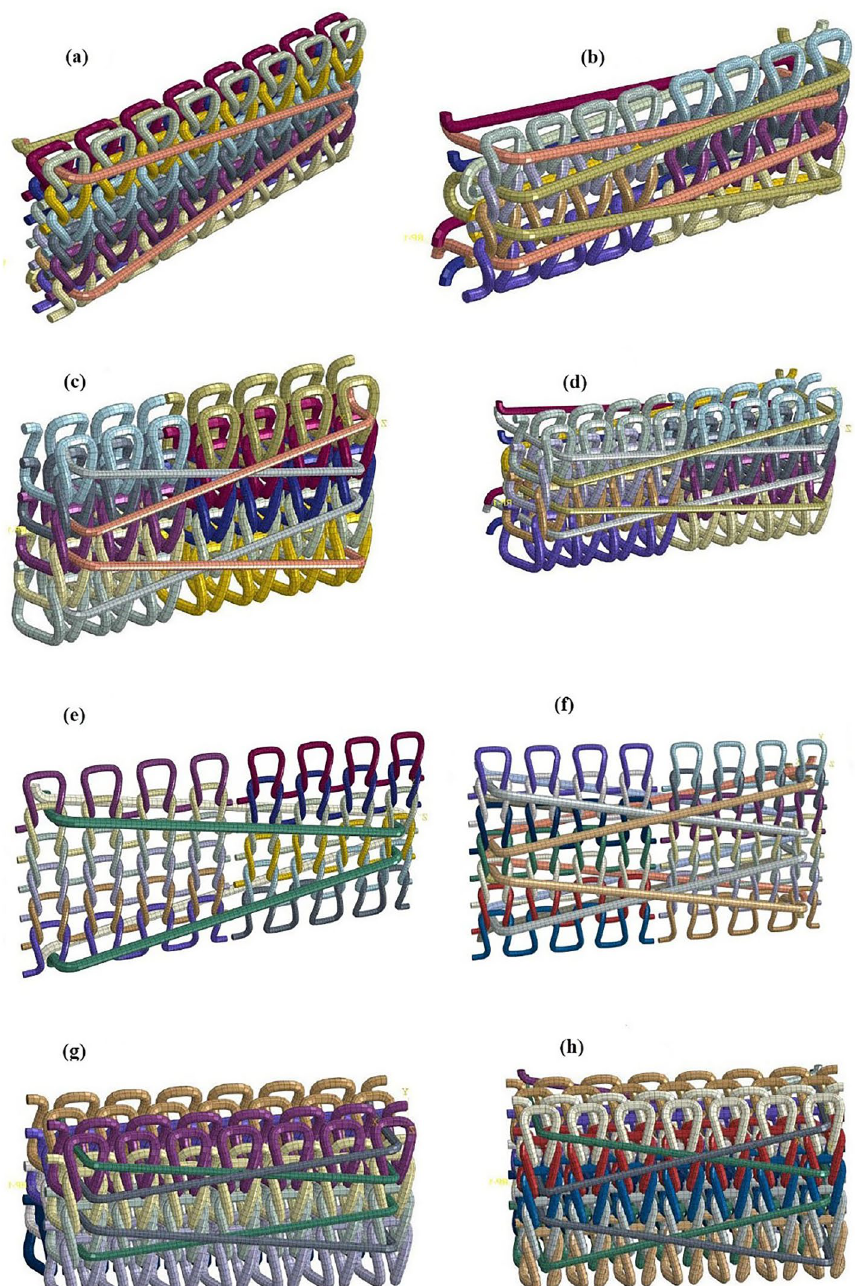
Fig. 2 All unit-cells of samples, a T1, b T2, c T3, d T4, e T5, f T6, g T7, h